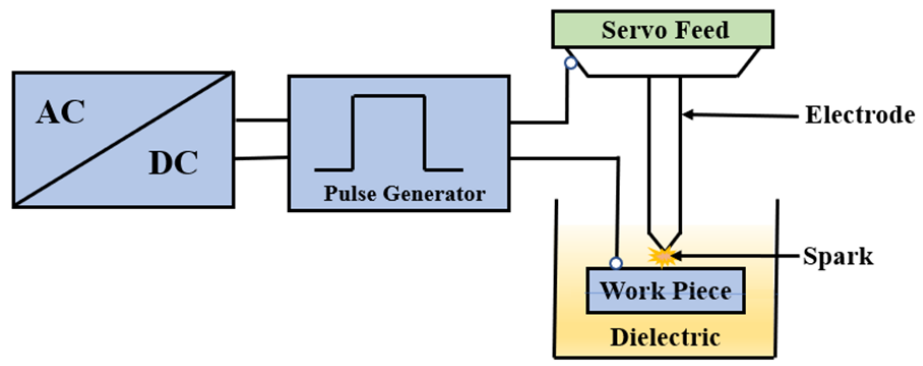
Figure 1. Functional block diagram of the proposed system.